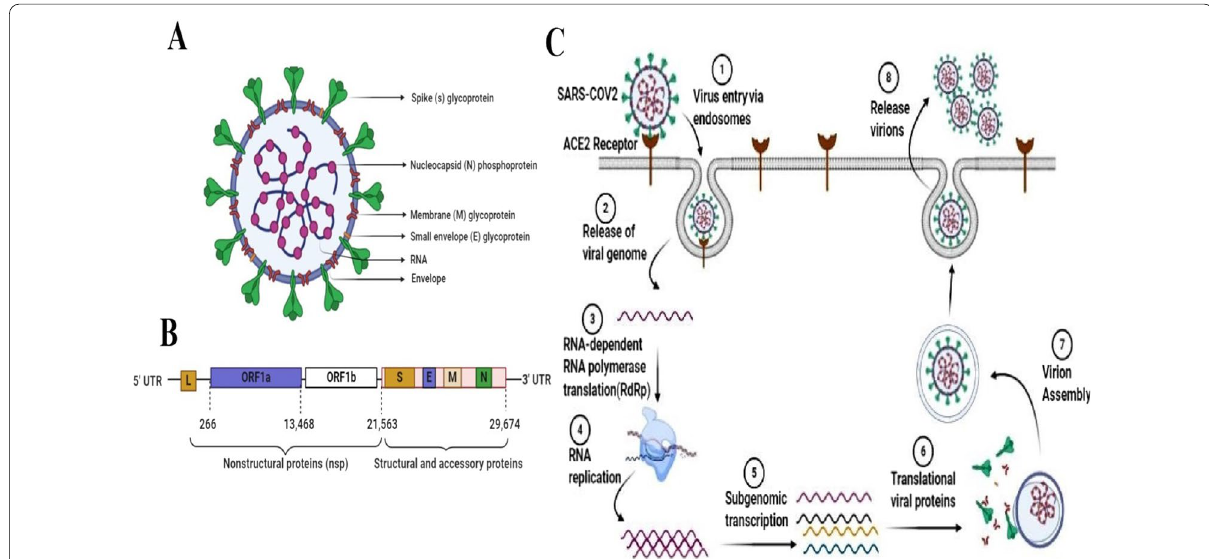
Fig. 1 Schematic representation of SARS-COV-2 structure and life cycle. A structure of SARS-CoV-2; the crown-like spike proteins (S) are placed on the outside of the viral envelope. B SARS-CoV-2 genomic structure; SARS-CoV-2 genome consists of the 5 ′ -untranslated region (5 ′ -UTR), nonstructural proteins region, structural and accessory proteins region, and the 3 ′ -untranslated region (3 ′ -UTR). C life cycle of SARS-CoV-2 in host cells; virus starts its life cycle by binding of S1 protein to the cellular receptor ACE2 and then proteolytic cleavage in the S protein facilitates the fusion of viral and cellular membranes by S2 protein. After the release of the viral genome into the cytoplasm, viral RNA replicates, and then viral proteins translate from the RNA and then viral proteins and genome are assembled into virions in the endoplasmic reticulum and Golgi. Eventually, Virions are transported by vesicles to near the cell membrane and released out of the infected cell by budding from the cytoplasmic